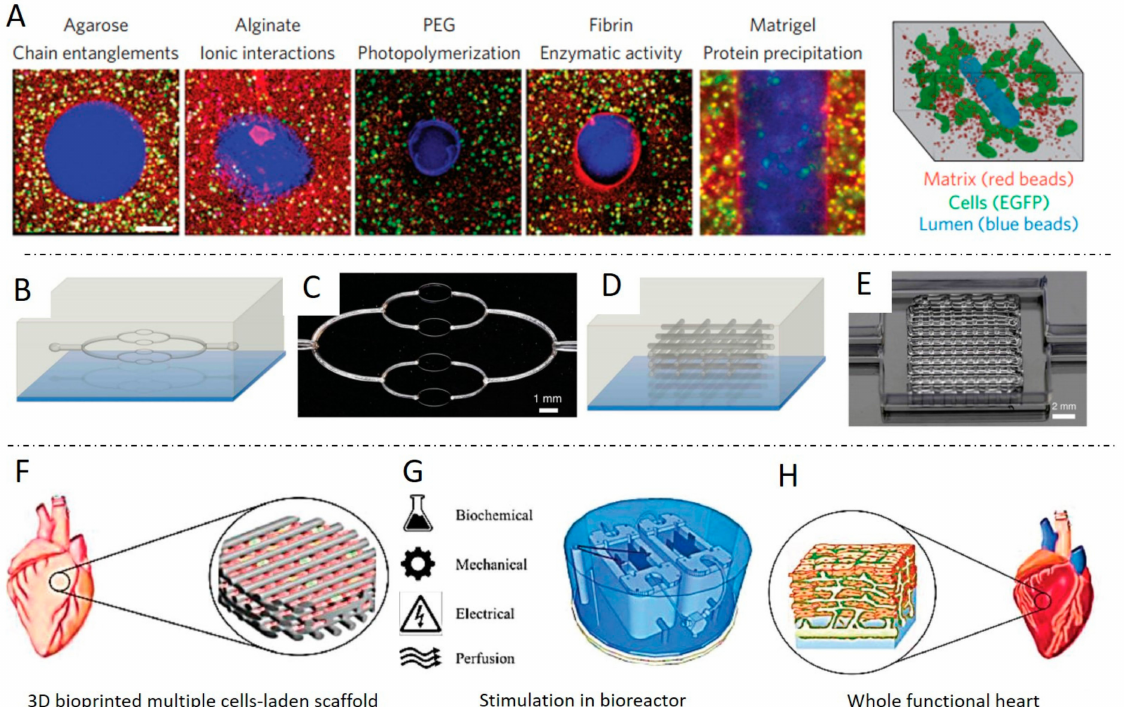
Figure 3. Examples of future perspectives of 3D bioprinting cell-laden scaffolds for tissue regeneration. ( A ) Carbohydrate glass to cast vascular features into a variety of hydrogels, forming perusable vessels that support cell growth. Schematic illustrations and optical images, of 2D ( B , C ), and 3D ( D , E ) embedded vascular networks that are printed, evacuated, and perfused with a water-soluble fluorescent dye. ( F – H ) A whole functional heart is formed from 3D bioprinted multiple cells-laden scaffolds cultured in the complex bioreactor combined with different stimulations. Pictures modified with permission from references